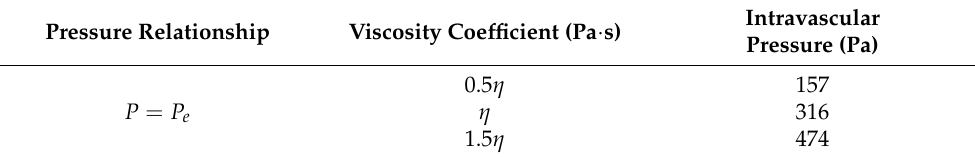
Table 3. Simulation results of intravascular pressure under different viscosity coefficients.